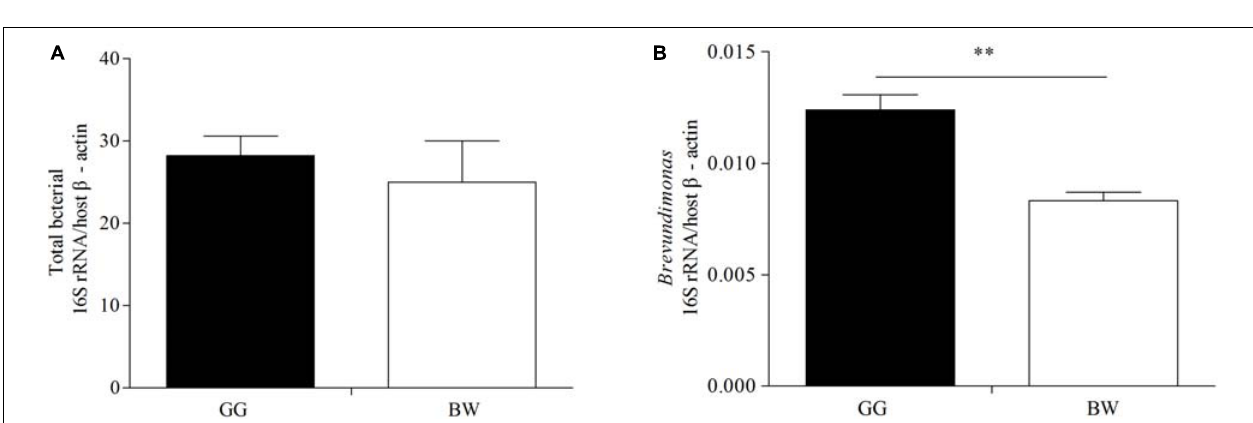
FIGURE 3 | Relative abundance of the genus level in guts of noble scallops. Sample from GG1 to GG5 was collected from GG, and sample from BW1 to BW5 was collected from BW, respectively. Groups within the same bacterial genus are indicated by different shades of the same color.